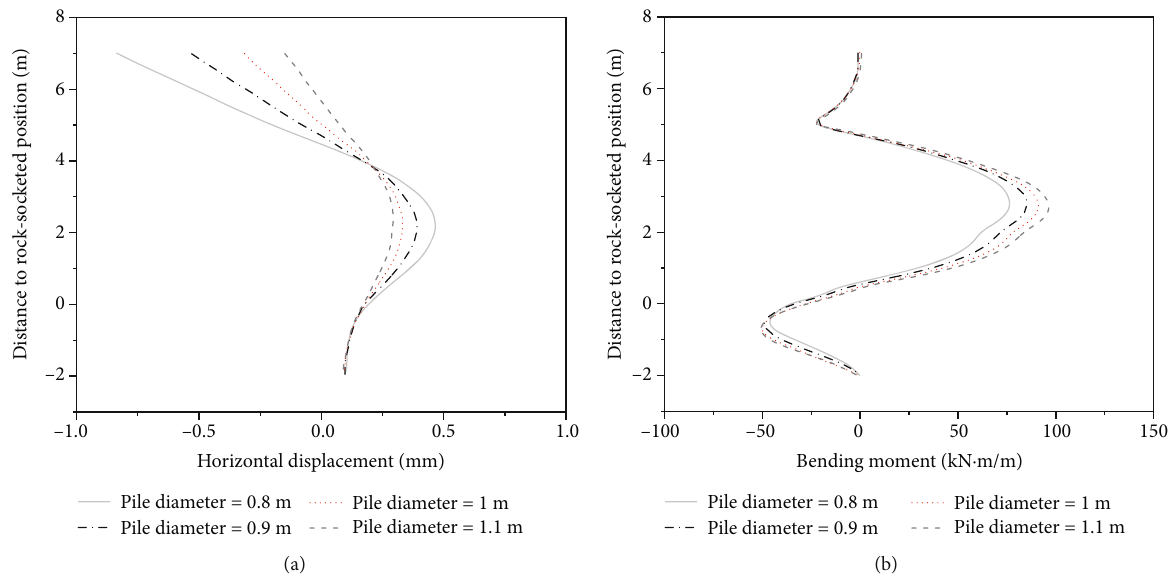
Figure 19: E ff ects of pile diameter on the horizontal displacement and bending moment of end-suspended pile. (a) Horizontal displacement. (b) Bending moment.